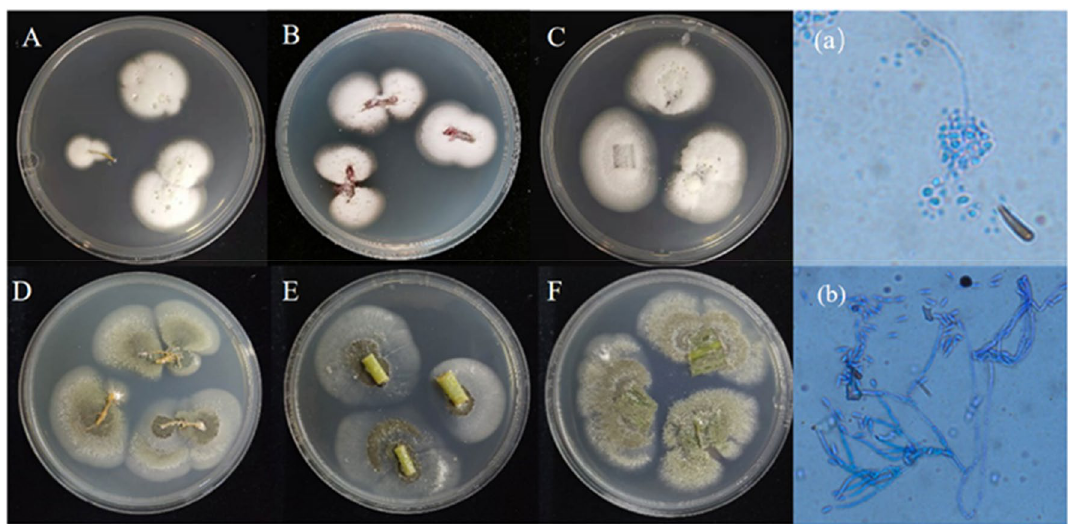
Table 3. Population dynamic of B. bassiana and M. anisopliae in the hydroponic solution in terms of CFUs (cps/ml).